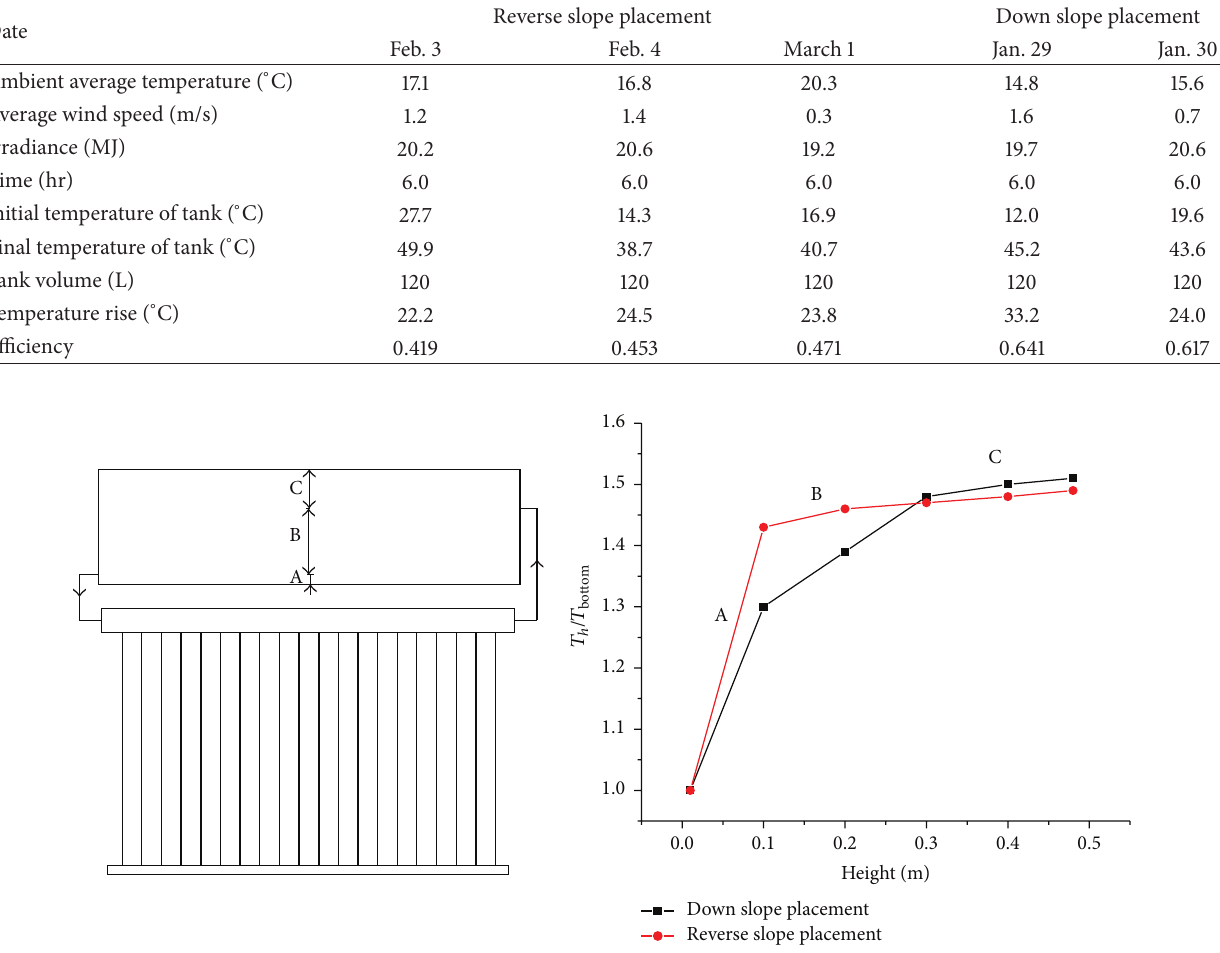
Table 6: Experimental performances of all-glass vacuum tube solar water heaters with collectors at down slope placement and at reverse slope placement.